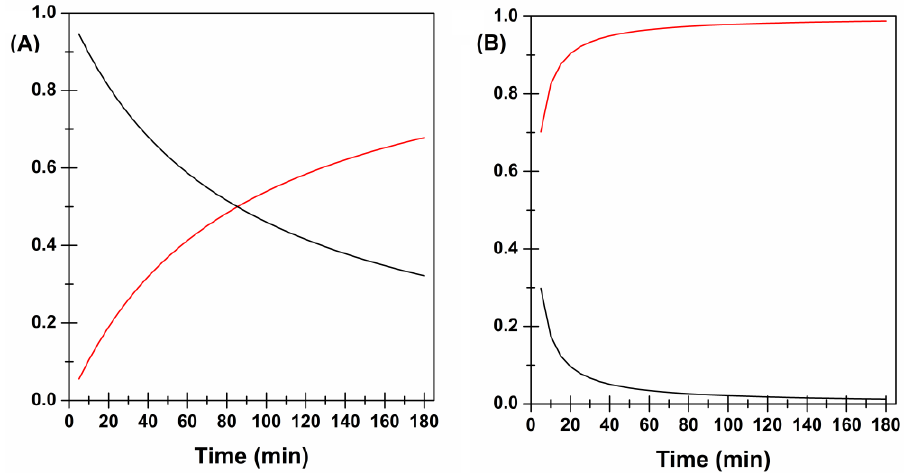
Figure 6. Diffusion (F–black) and Relaxation (R-red) contributions in the CYT release process from Film B ( A ) and Film C ( B ) as a function of time. Film B initially displayed a release mechanism mainly governed by diffusion. How- ever, after 80 min of experiment, a trend reversal was observed, and the relaxation contri- bution became dominant. This is probably due to xylitol (and other water-soluble compo- nents) dissolution which over time lead to the creation of larger pores thus “relaxing” the whole structure. As already discussed, the insertion of PVP K90 may modify the whole polymer chain disposition, causing a variation in terms of matrix meshes, water uptake, and release pat- tern. According to the swelling data, PVP K90 decreases the water entry rate thus hinder- ing and slowing down drug diffusion through polymer chains. To permit a massive water uptake, PVP K90 chains must relax, causing a modification of the whole structure and consequently the solubilization of water-soluble molecules that lead to a further relaxa- tion. As a consequence, the relaxation process appears to be the predominant one. Fur- thermore, it should be noted that the effects of PVP K90 were not observed in FILM C as the influence of xylitol was predominant. 3.3. Interaction between CYT-Loaded Buccal Films and the Ex Vivo Porcine Mucosal Tissue The terms mucoadhesion or bio-adhesion indicate the adhesion of the drug delivery system to the mucosal membrane epithelium. When the drug is intended to be adminis- tered through the transmucosal routes (e.g., when administered by a buccal thin film) in- creasing the residence time of the formulation in the mouth can potentially help to en- hance bioavailability and absorption rate. The mucoadhesion phenomenon is a complex process which depends on the interaction between the application site and formulation. Due to its complexity, mucoadhesion could be explained by several theories (wetting, fracture, diffusion-interlocking, electronic, adsorption, and dehydration theories). Gener- ally, it is schematized in two main stages: the contact stage and the consolidation stage. During the contact stage, the drug delivery system approaches the mucosa, and here it is wetted. The main factors affecting the contact stage are the formulation capability of hy- drating and its ability to spread the interfacial forces between the material and the mucosa. In the consolidation stage, various physicochemical interactions between the formulation, the mucus layer, and the mucosal membrane take place (physical entanglement as well as chemical bonds) resulting in a prolonged adhesion [38]. The mucoadhesion evaluations were conducted by using the method of the two-arms modified balance. The latter consists